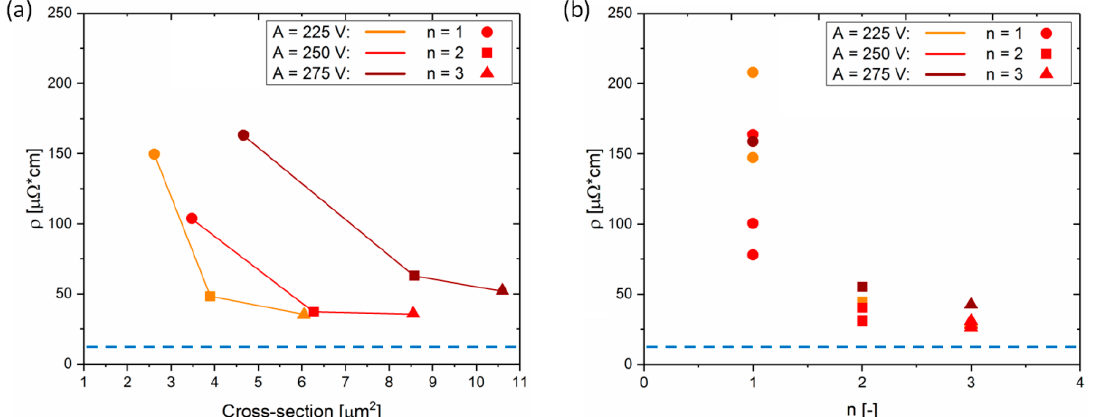
Figure 9. Summary of the resistivity measurements of single and multilayer overprints. ( a ) Two-point probe resistivity as a function of the overprint cross-section for different A . ( b ) Resistivity presented as a function of number of printed layers ( n ). The blue dashed lines represent the resistivity reported by the ink supplier. B = 200 V, f = 100 Hz.